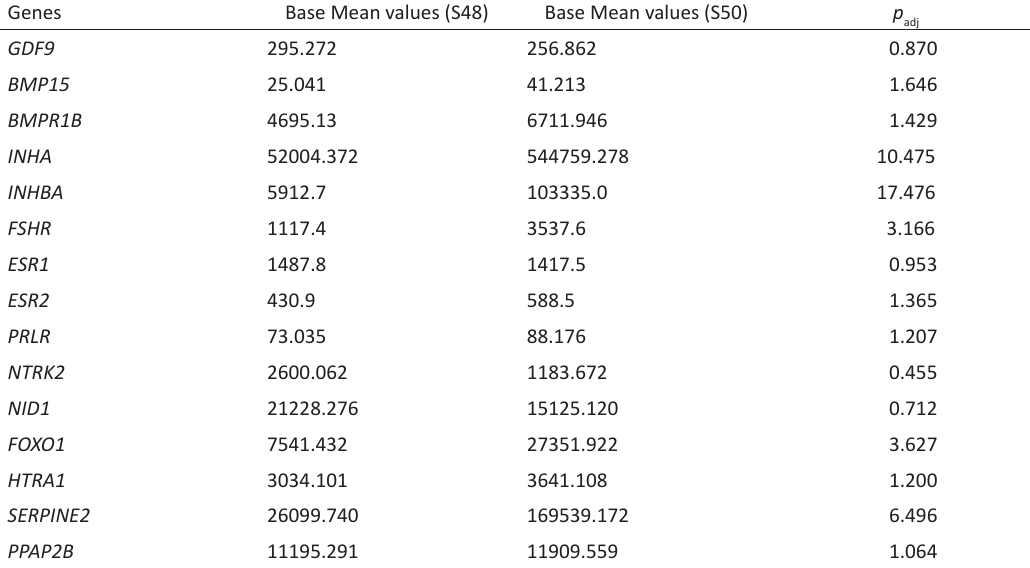
is the adjusted p value. adj